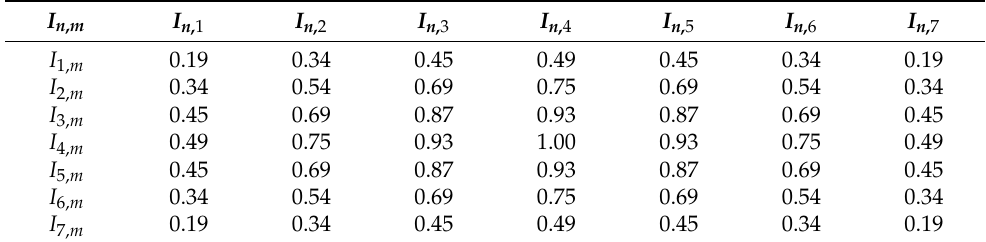
Table 1. Distribution of raised cosine amplitude proposed for the 7 × 7 planar array considering a value of a = 0.19 and a SLL PEAK = − 20 dB.